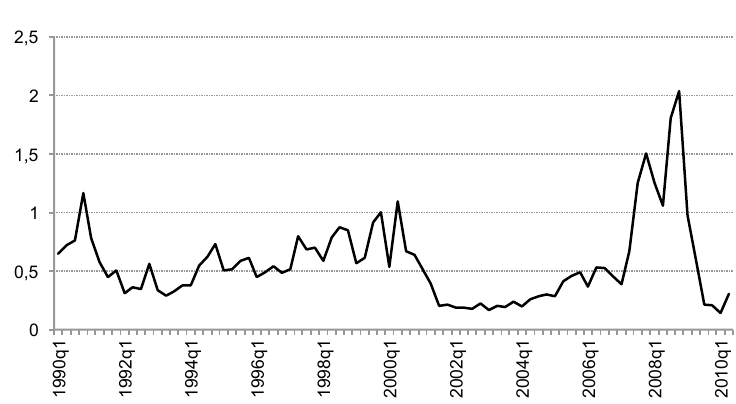
Relative cost of short-term financing